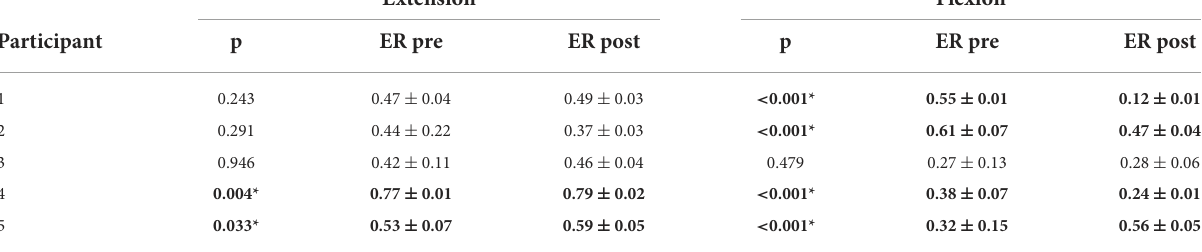
TABLE 3 Muscle individuation during extension and flexion tracking.